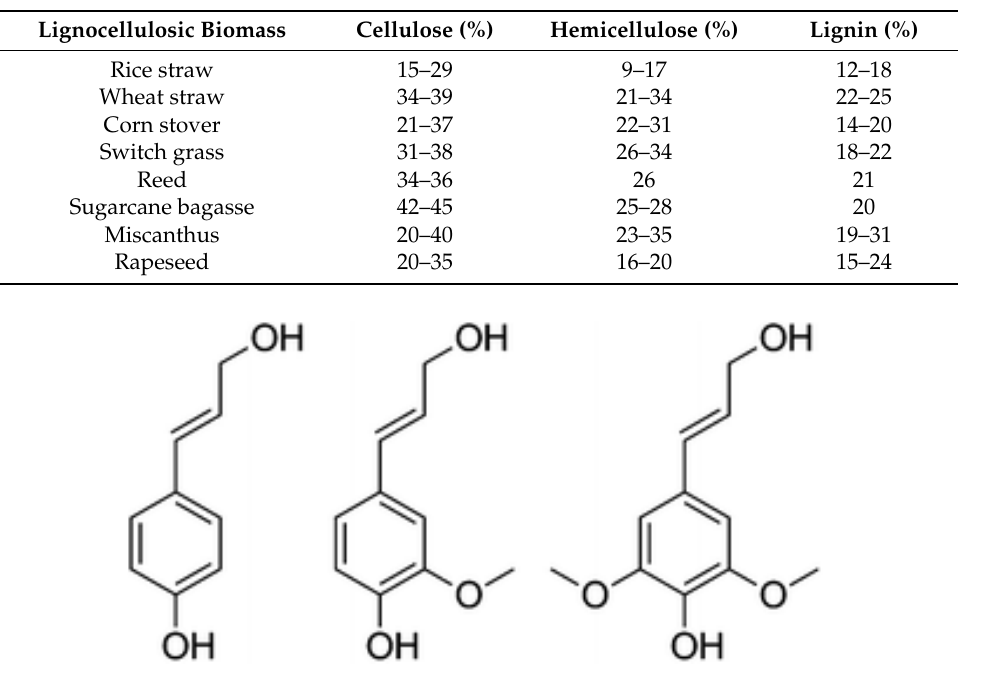
Table 1. Composition of lignocellulosic biomass [12].